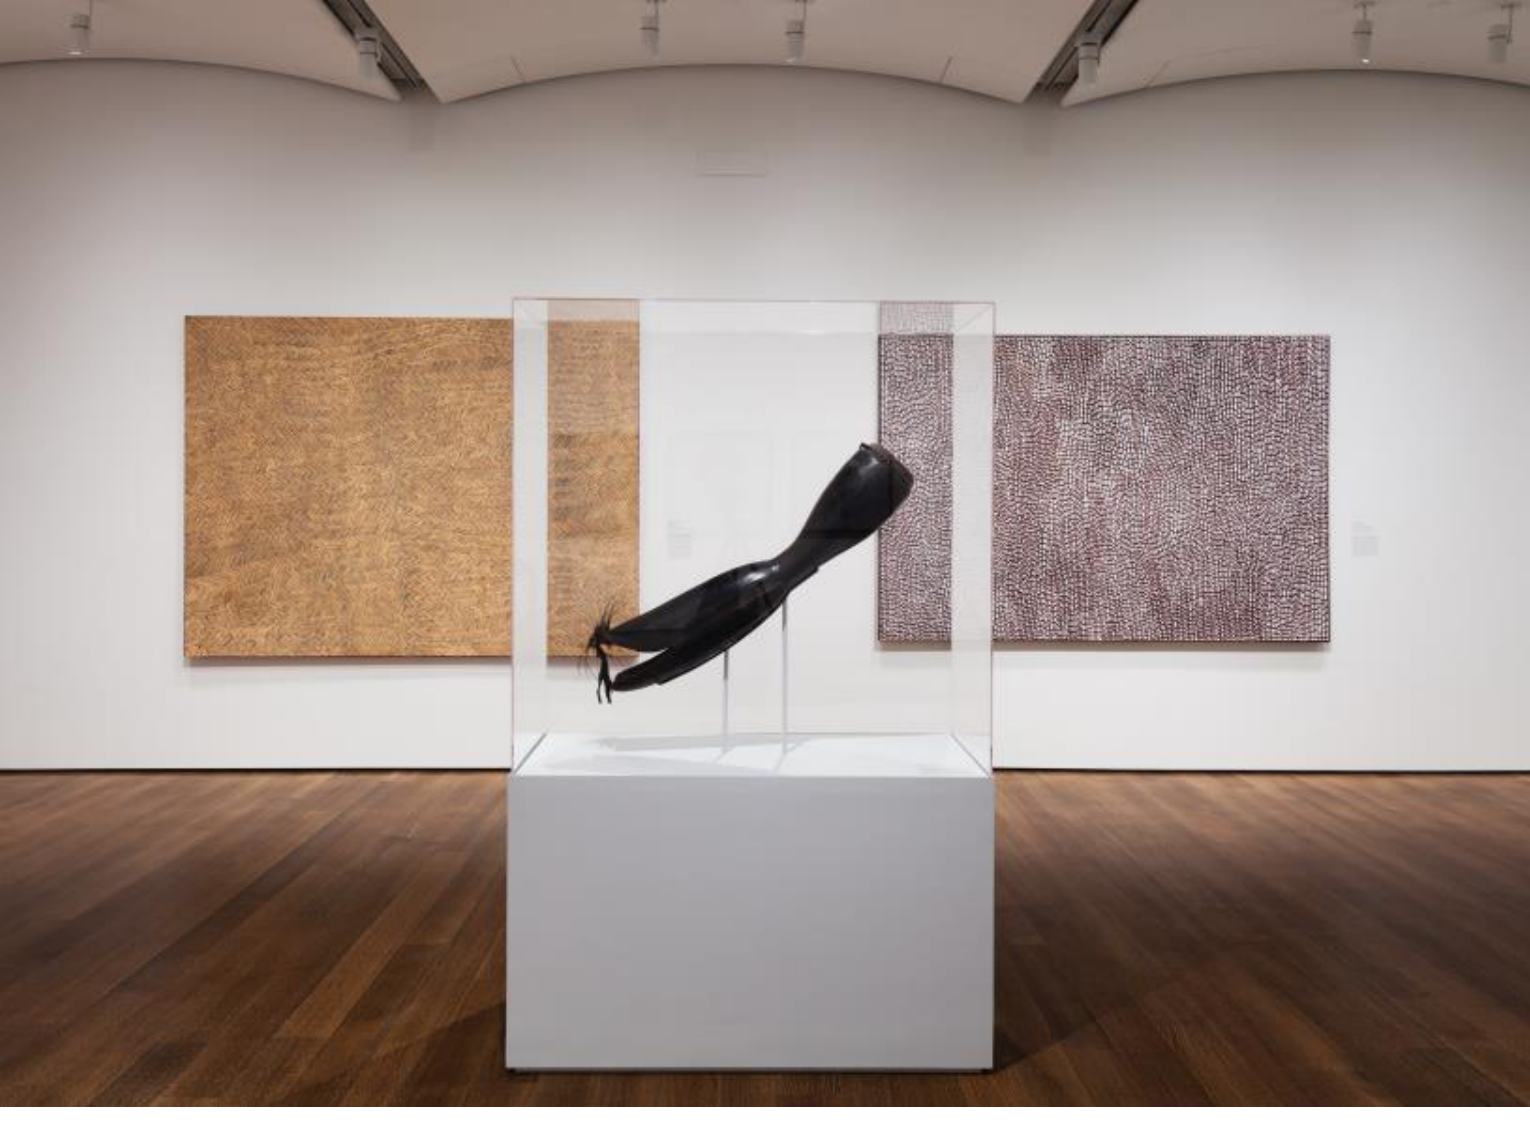
Contemporaneity: Historical Presence in Visual Culture http://contemporaneity.pitt.edu Vol 5, No 1 “Agency in Motion” (2016 ) | ISSN 2155-1162 (online) | DOI 10.5195/contemp.2016.183